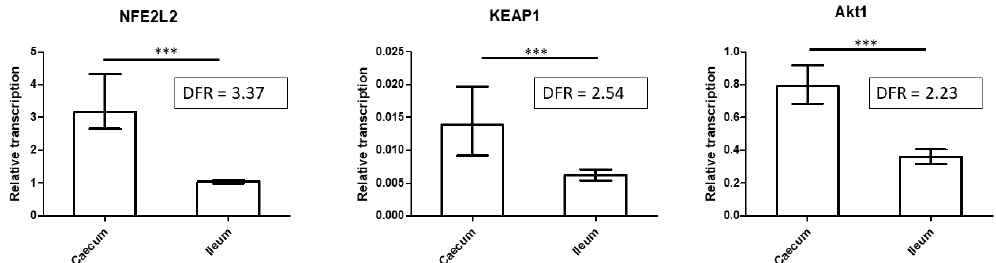
Figure 3. mRNA expression of NFE2L2, KEAP1, and AKT1 in the caecum and ileum. A higher level of transcription of NFE2L2, KEAP1, and AKT1, oxidative stress transcriptional regulators, was recorded in the caecum than in the ileum (Mann–Whitney, *** indicate p < 0.0005). DFR = differential fold ratio.